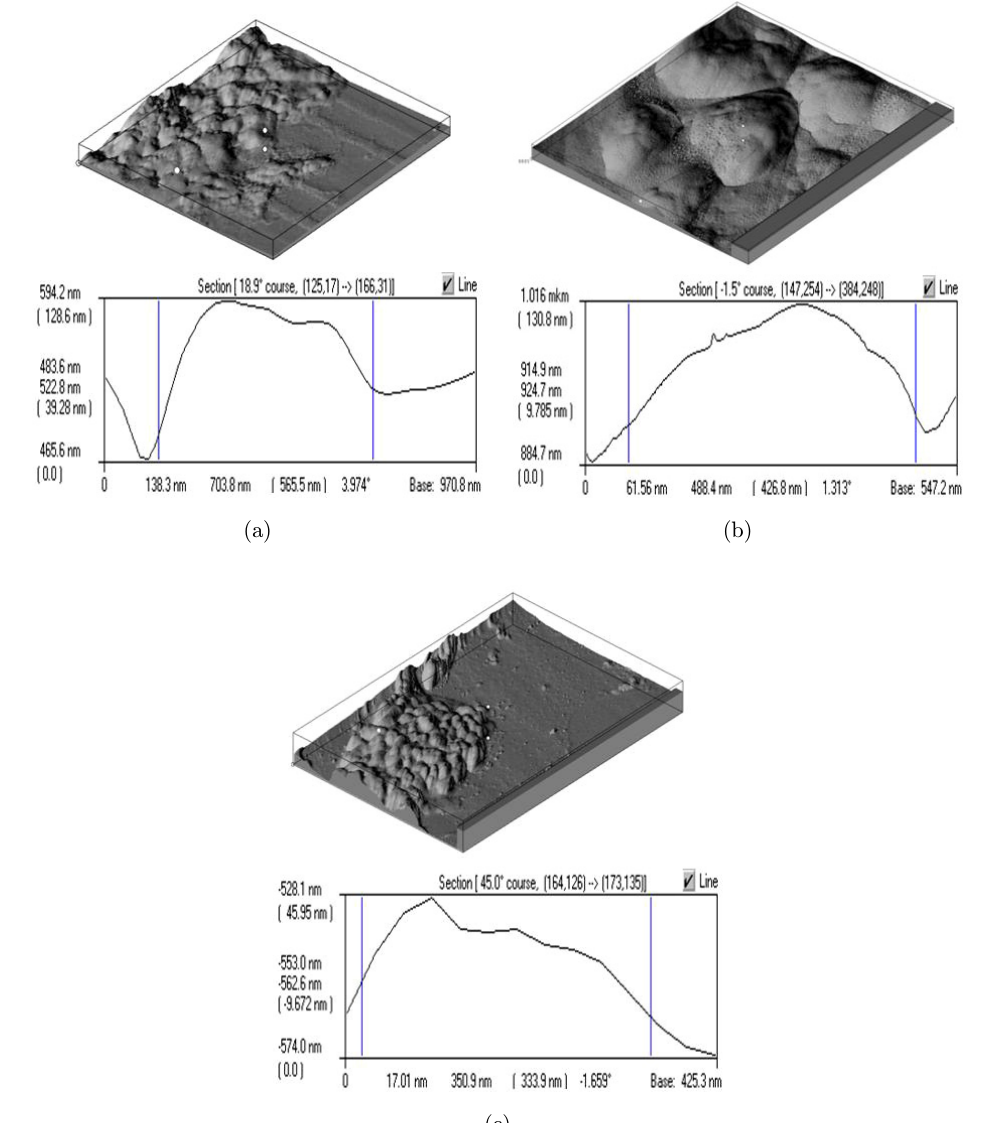
Fig. 3. AFM pictures of external wool layer of healthy mice (a) and mice with small (b) and large (c) tumor.